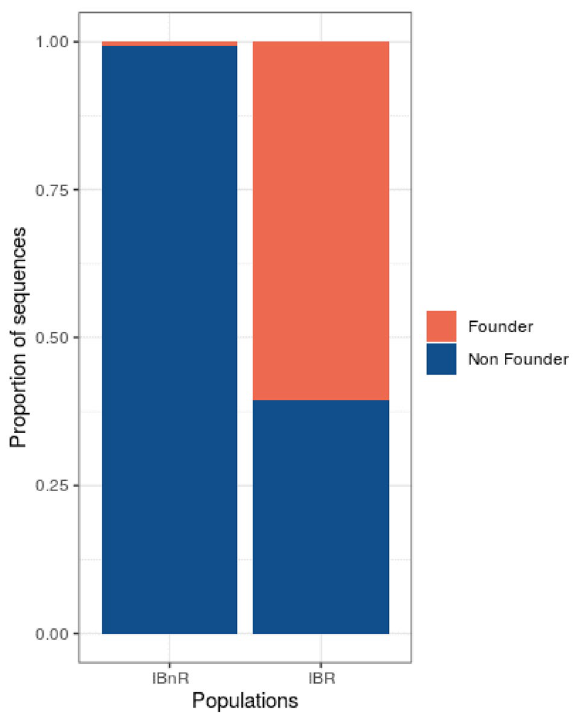
Figure 6. Proportion of population specific founder and non-founder lineages in the Iberian Roma (IBR) and Iberian non-Roma (IBnR)